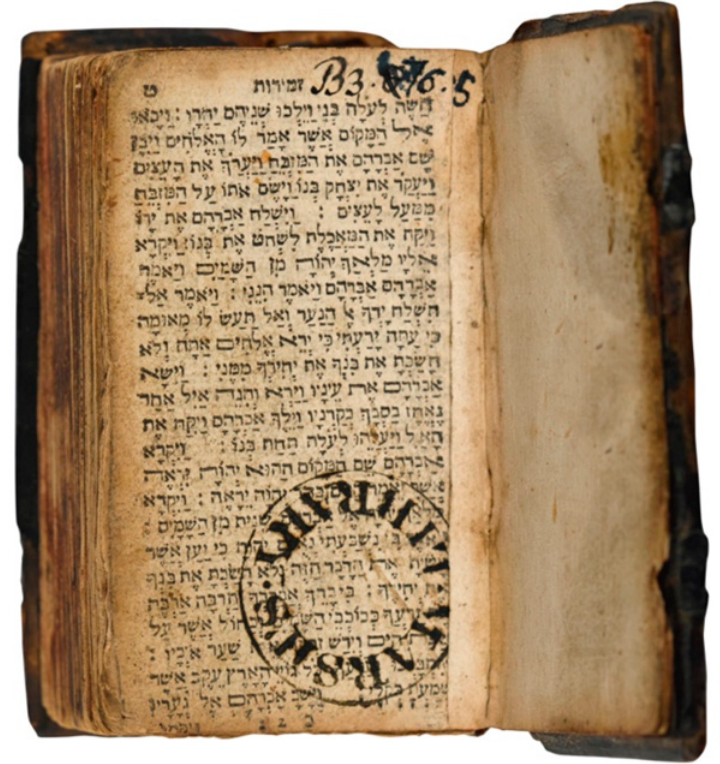
Figure 29. Small Prayer Book with Pirkei Avot; Marsh’s Library B.3.6.5.